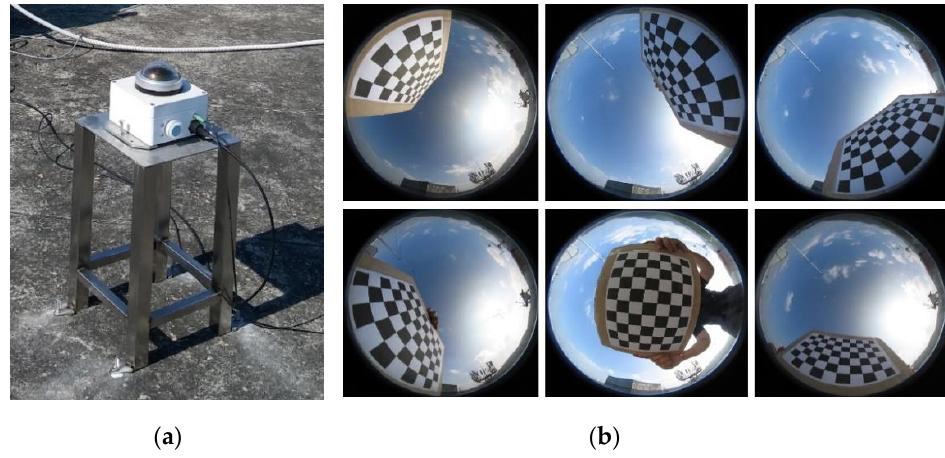
Figure 1. An instrument to record sky image data. ( a ) Total Sky Camera J1006; ( b ) sky camera calibration using the checkerboard image.